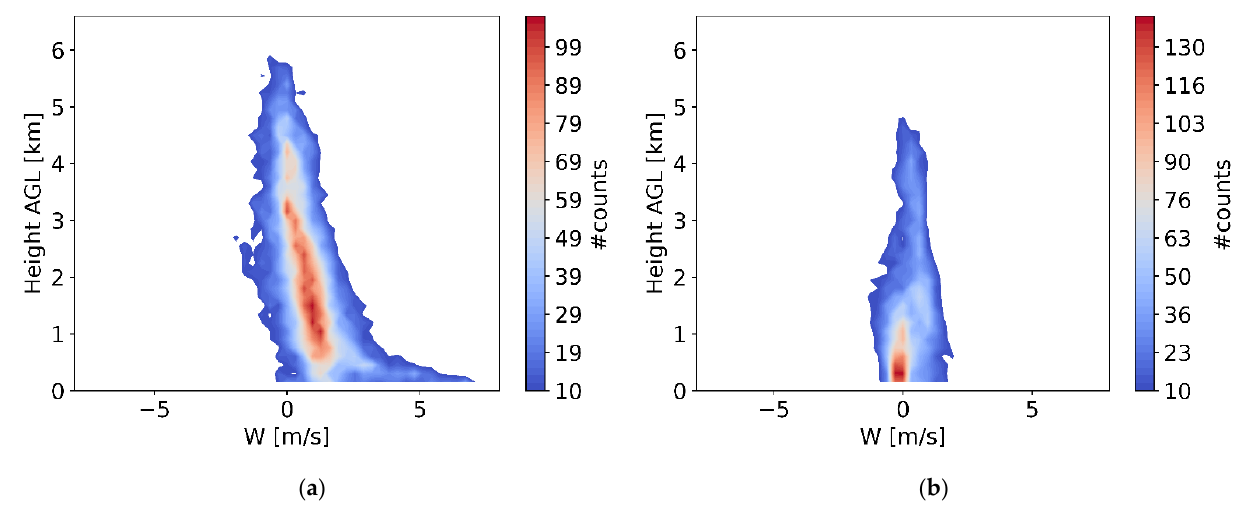
Figure 11. Contour frequency altitude diagram of vertical speed computed with RWP Method2 for 24 to 25 March 2017 considering: ( a ) rainy conditions (rain flag on), ( b ). non-rainy conditions (rain flag off). Frequencies of counts are shown in abso lute terms.